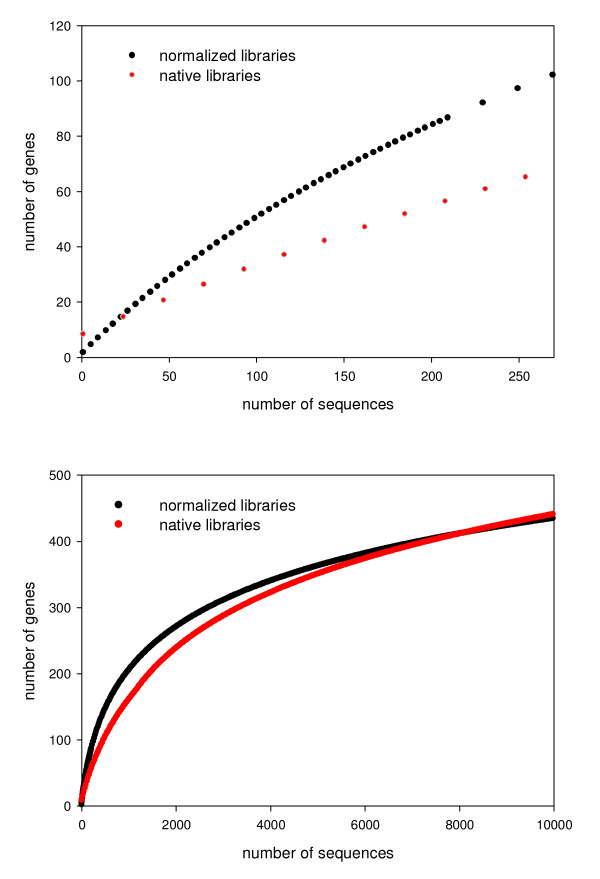
Rarefaction curves illustrating gene discovery (number of genes) as a function of effort (number of sequencing reads). (a) Rarefaction analysis comparing empirical gene discovery between normalized and native libraries. (b) Rarefaction analysis comparing simulated gene discovery between normalized and native libraries.